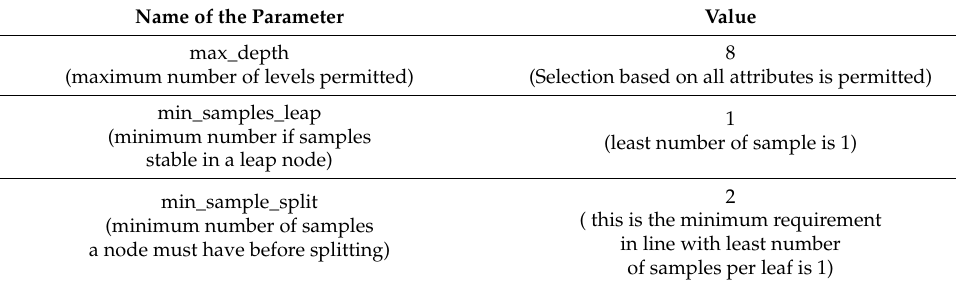
Table 2. Parameters of Decision Tree and Its